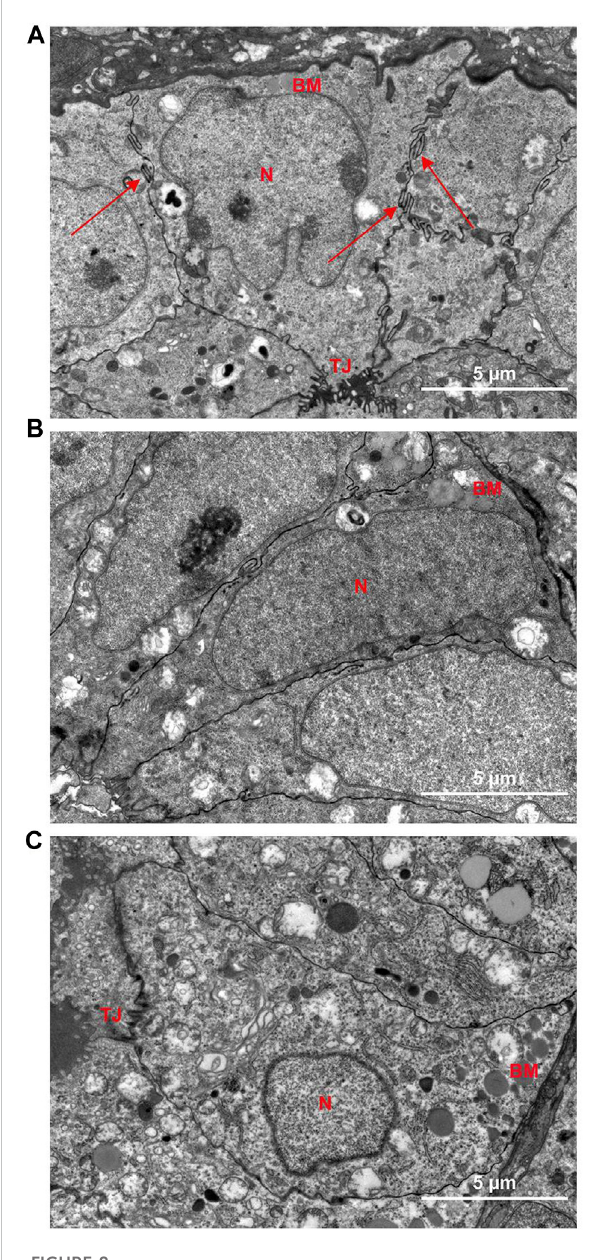
FIGURE 8 Representative electron microscopy images of the uterus of Control group (A) and Modelgroup (B) andDTtreatment group (C) .N, nuclei; BM, basement membrane; TJ, tight junction; Red arrows, fi nger-like